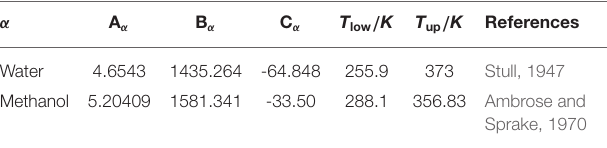
TABLE 3 | Antoine parameters for pure water and methanol for the relevant temperature